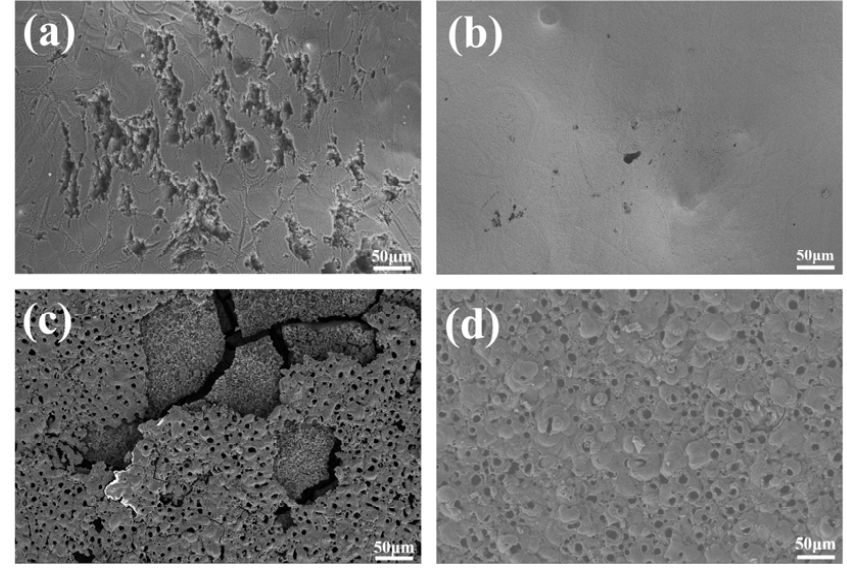
Figure 11. Post ‐ corrosion morphologies of samples: ( a ) CG; ( b ) SFT; ( c ) CG ‐ MAO; ( d ) FG ‐ MAO. Figure 11. Post-corrosion morphologies of samples: ( a ) CG; ( b ) SFT; ( c ) CG-MAO; ( d )